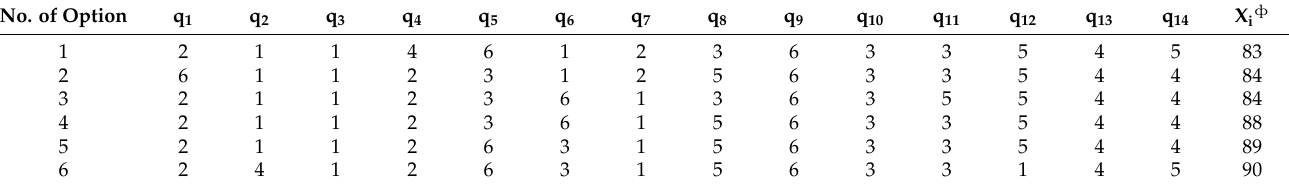
Table 6. Result of constructive enumeration subject to constraints.